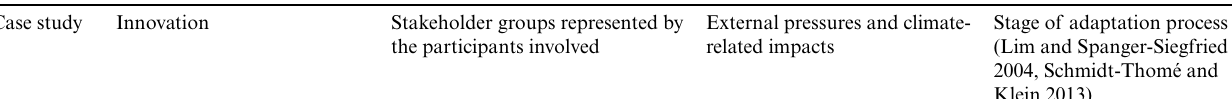
Table 1. Characterization of two participatory action-research case studies in Portugal, in the context of climate change